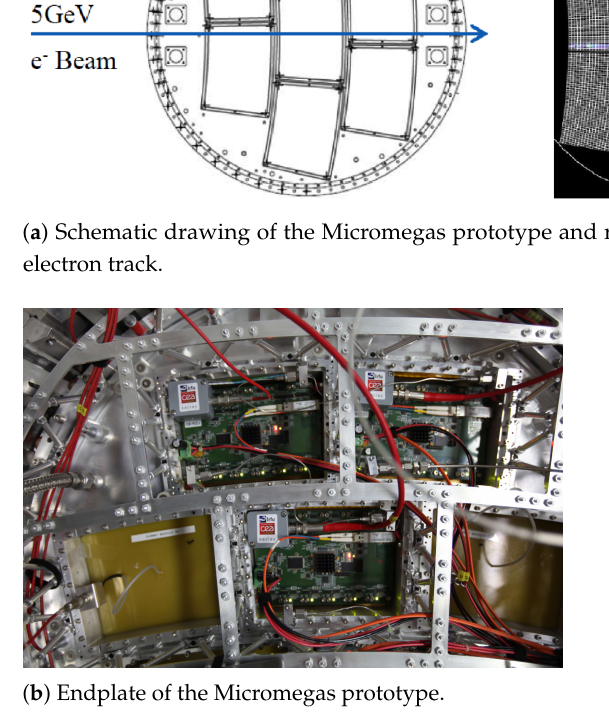
Figure 17. The Micromegas Large Prototype of the LCTPC collaboration at the DESY II beam test